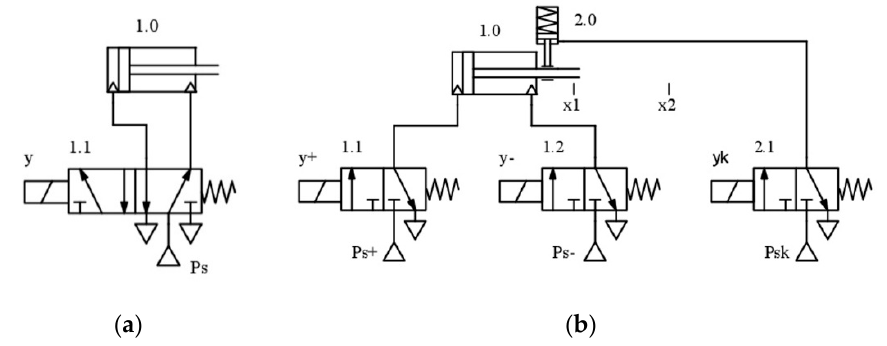
Figure 1. A pneumatic executive system: ( a ) typical; ( b ) with different levels of compressed air pressure and holding the cylinder piston rod in its final position.